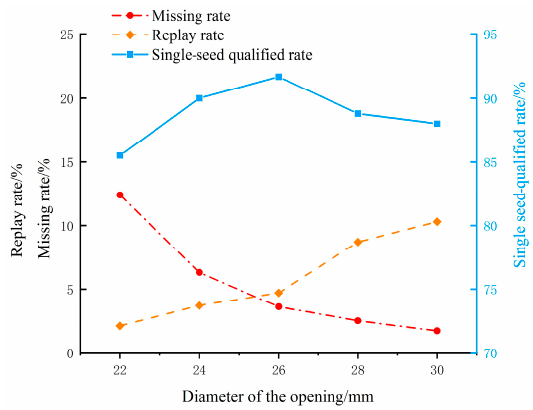
Figure 11. Relationship with evaluation indicators under different opening radii.